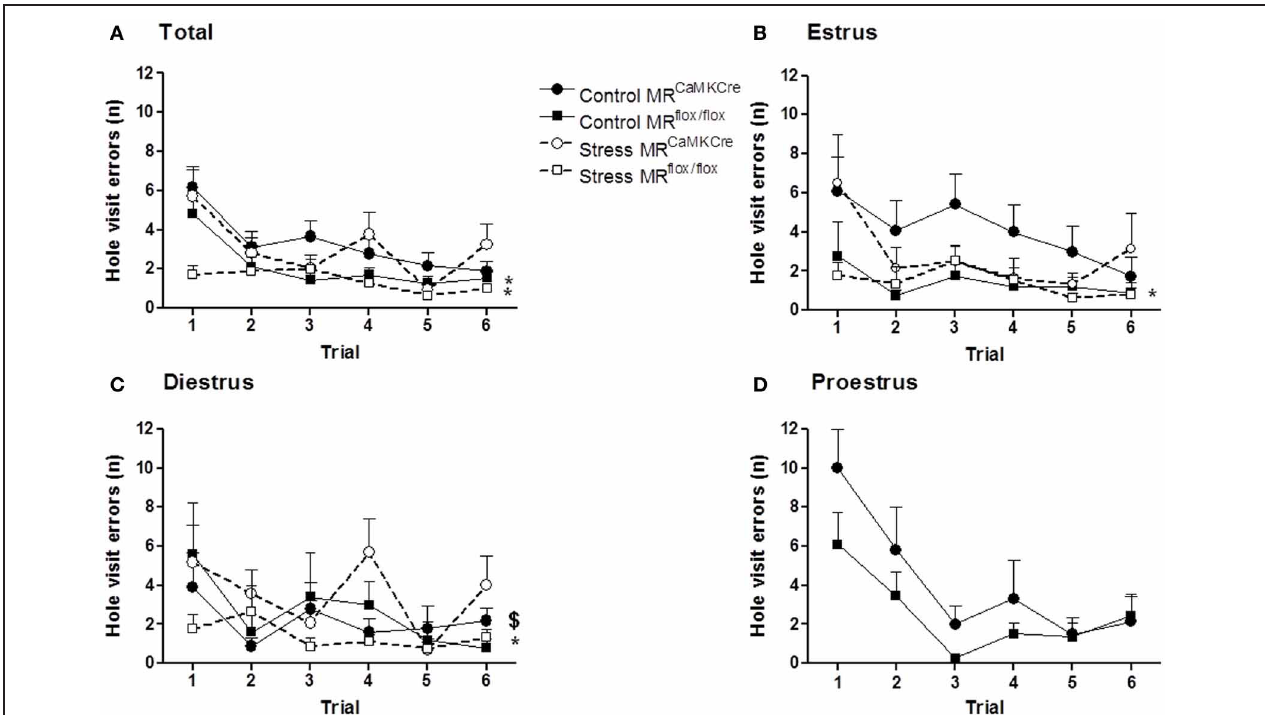
circles with the solid line are control MR CaMKCre mice and black squares with a solid line represent control MR flox / flox mice. White circles with a dotted line are stressed MR CaMKCre mice and white squares with the dotted line represent stressed MR flox / flox mice. ∗ p < 0 . 05, compared to MR CaMKCre same estrous cycle phase; $ p < 0 . 05, compared to estrus within MR CaMKCre